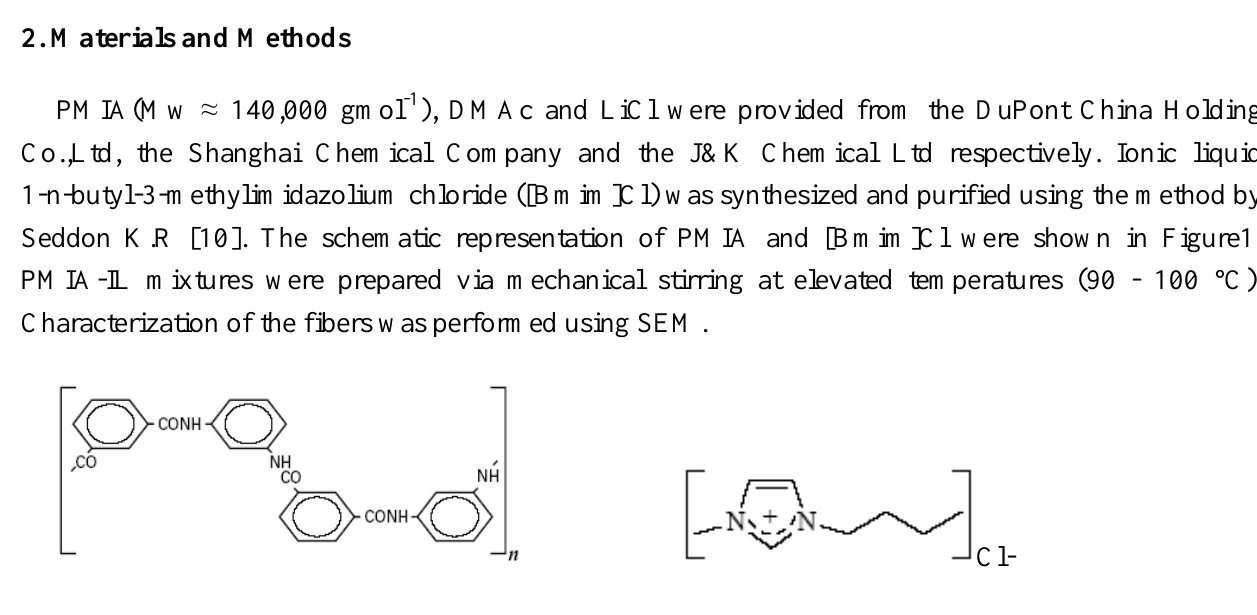
Figure 1. The schematic representation of Poly(m-phenyleneisophthalamide) (PMIA) and 1-n-butyl-3- methylimidazolium chloride